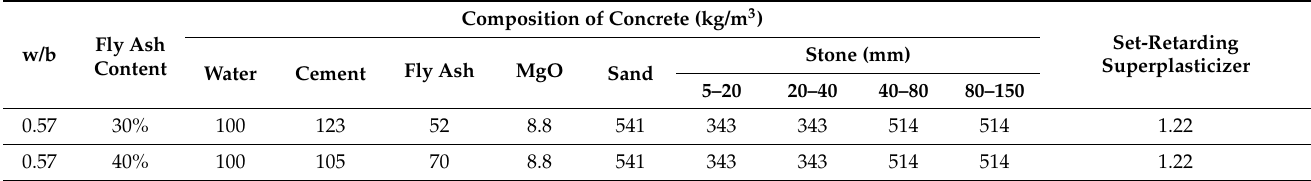
Table 1. Component mass of oxygen magnesia concrete samples with varying fly ash contents. Fly Ash Content